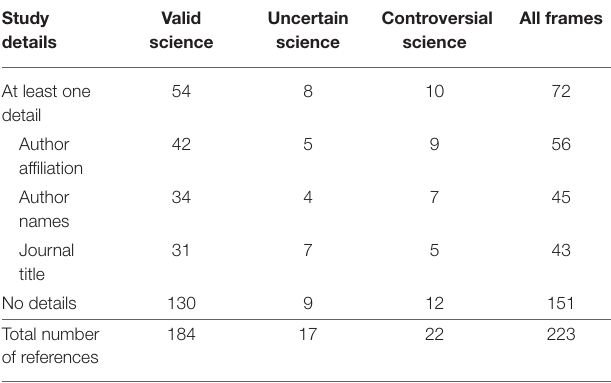
TABLE 4 | Research references that provided bibliographic information about the study, grouped by